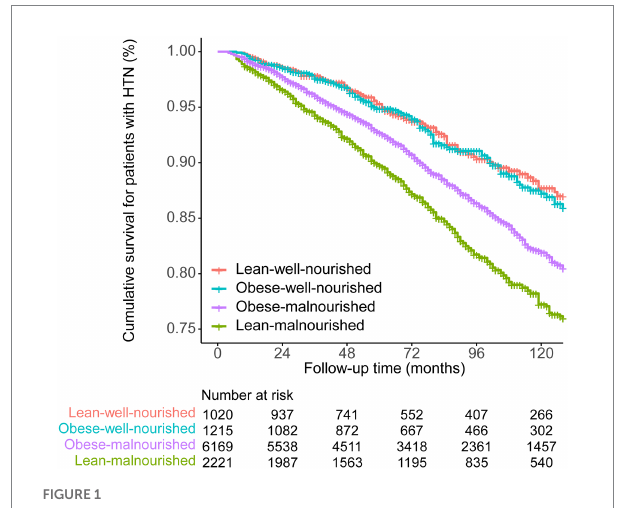
FIGURE 1 Kaplan–Meier survival curve of the four groups divided by obesity and nutrition